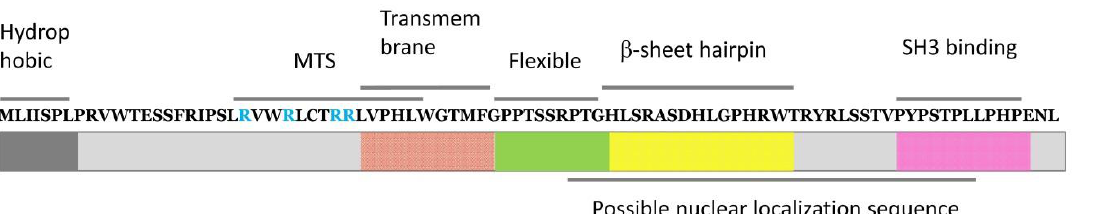
terminal followed by an amphipathic helix, which contains the mitochondrial targeting sequence (MTS); transmembrane helix; highly flexible region; predicted β-sheet region; SH3-binding sequence with PXXP motif; and possibly nuclear localization sequence. The arginines (R) in MTS are colored in blue.